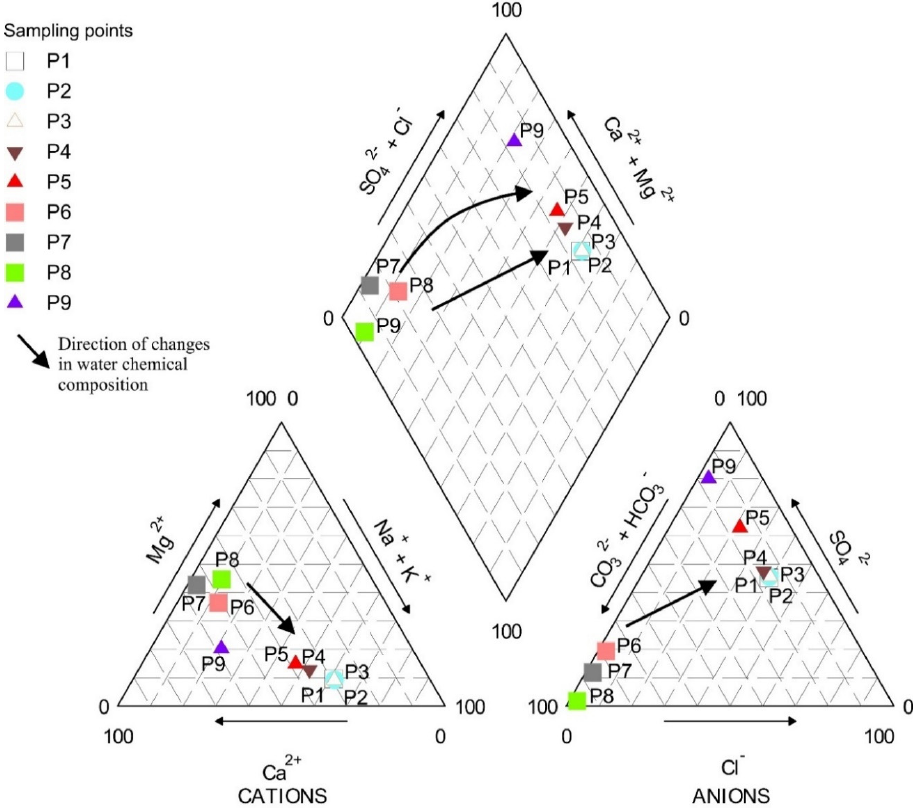
Figure 3. Hydrogeochemical characteristics of thermal water using the Piper Diagram.